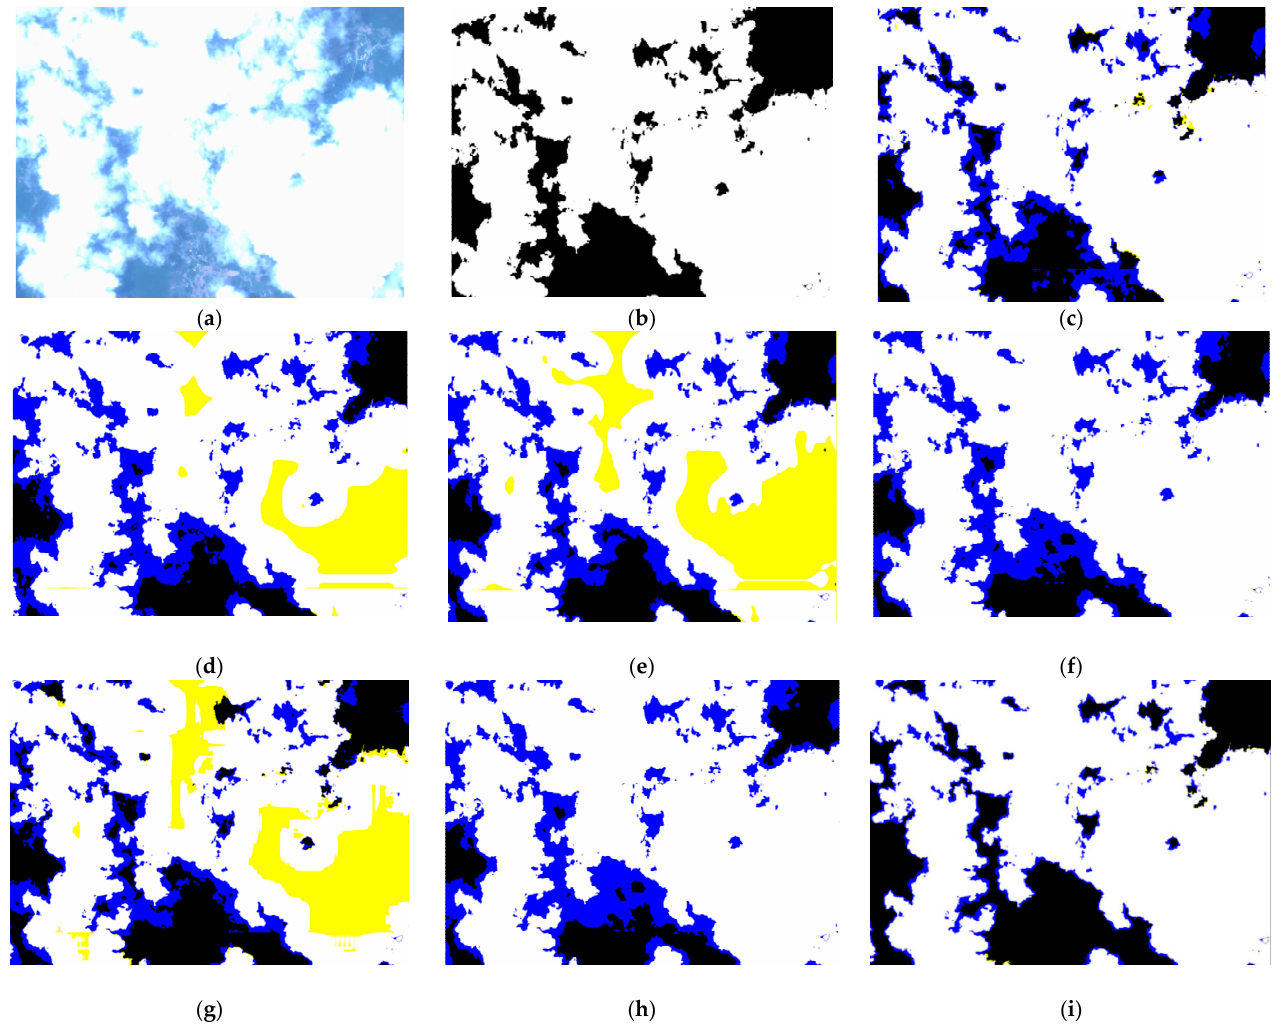
Figure 7. Detail comparison of different deep learning models at subregioin A (the yellow areas indicate missed extracted pixels and the blue areas indicate wrongly extracted pixels). ( a ) True color images. ( b ) ground truth. ( c ) DeeplabV3+. ( d ) MT-Unet. ( e ) MSCFF. ( f ) CDNet. ( g ) RS-net cloud. ( h ) GCDB-Unet. ( i ) ours.